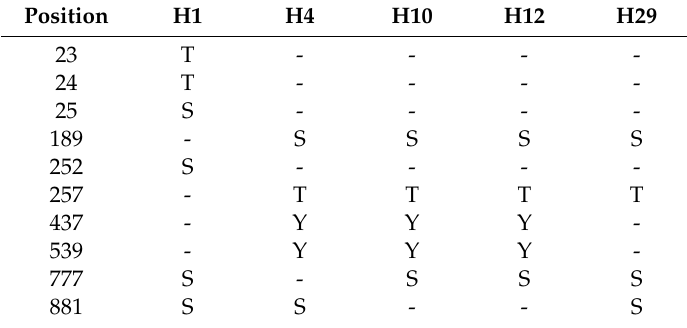
S = Ser; T = Thr; Y = Tyr; - No phosphorylation site at this